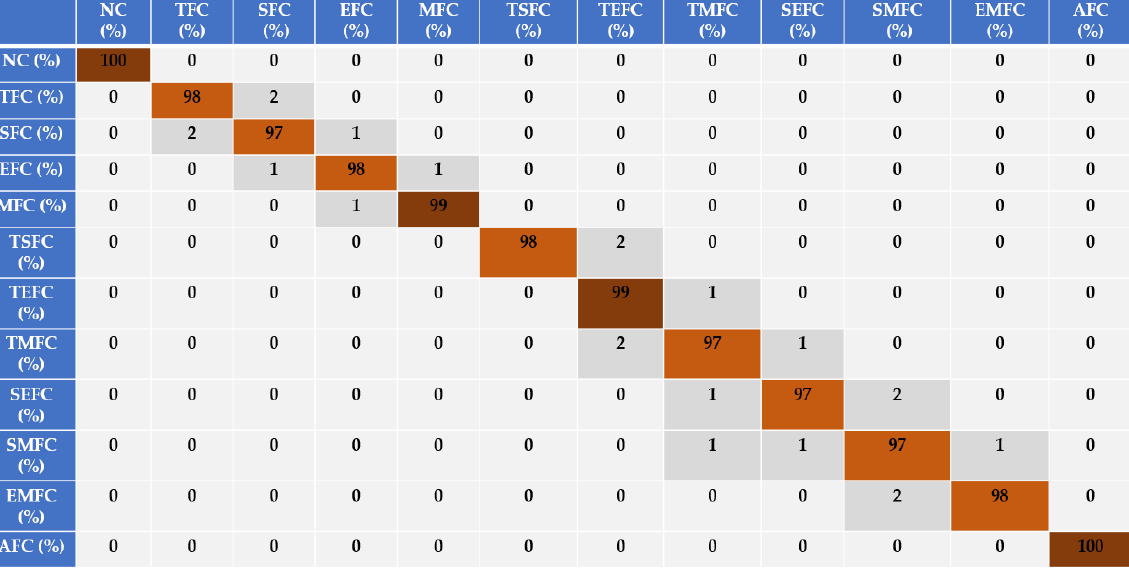
Figure 11. Sensor-fault-classification accuracy using FGAL-LCR and an SVM.